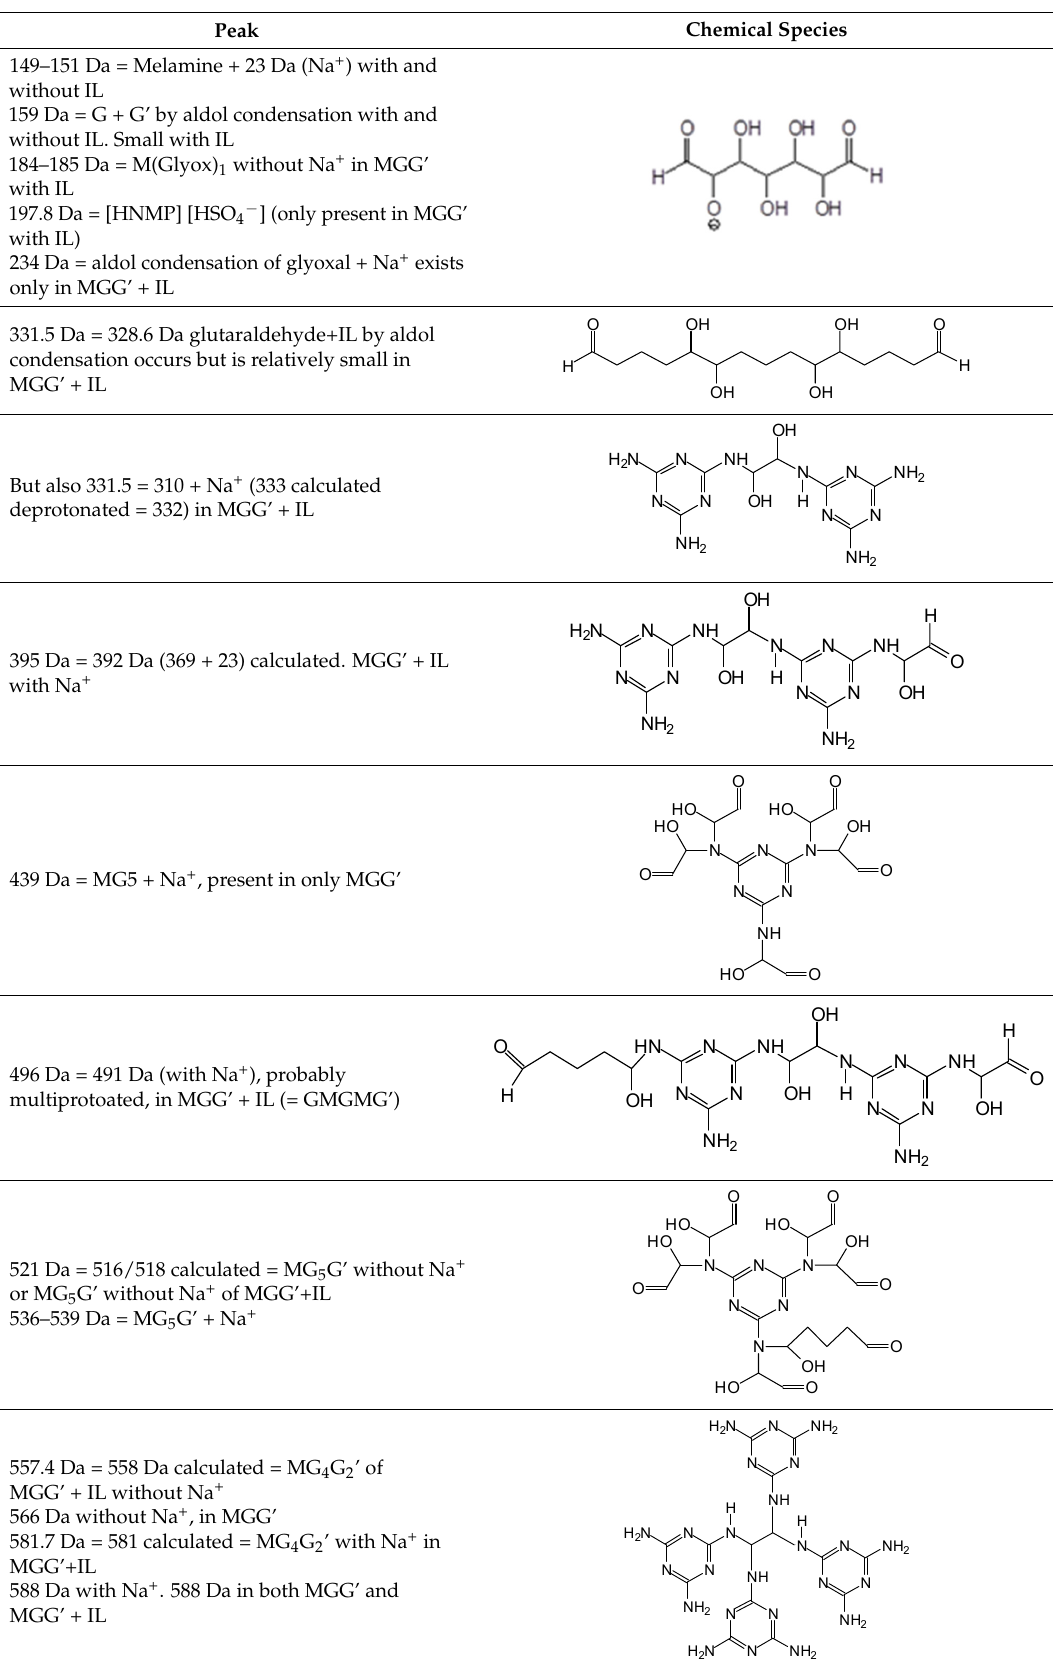
Table 6. Oligomers formed by the reaction of MGG’ with and without IL.